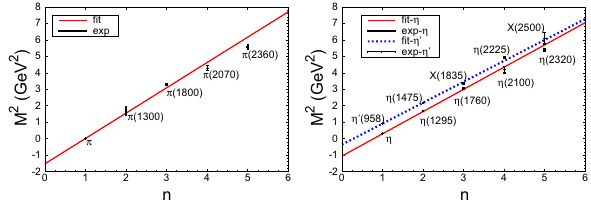
Fig. 1 The π , η , and η (cid:2) -trajectories with M 2 n = M 2 fitting to the experimental masses of the mesons. π -trajectory: M 2 0 . 019480 ± 0 . 000001 GeV 2 , μ 2 = 1 . 5387 ± 0 . 0165 GeV 2 , χ 2 / d.o.f = 49 . 7 /( 5 − 2 ) ; η -trajectory: M 2 1 . 3511 ± 0 . 0084 GeV 2 , χ 2 / d.o.f = 27 . 9 /( 5 − 2 ) ; η (cid:2) -trajectory: M 2 0 . 91734 ± 0 . 00115 GeV 2 , μ 2 = 1 . 2723 ± 0 . 0092 GeV 2 , χ 2 / d.o.f